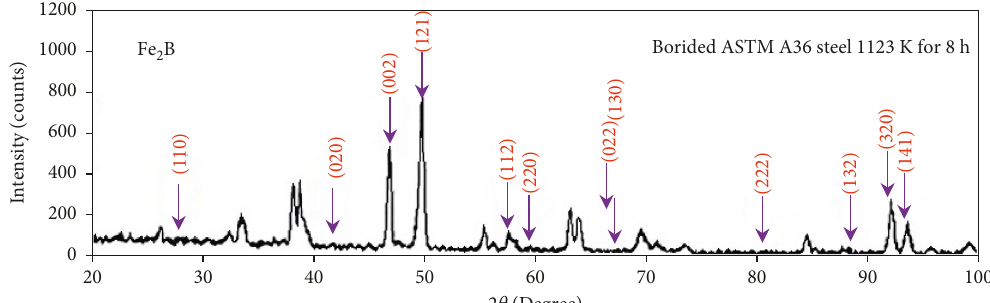
Figure 6: XRD patterns obtained at the surface of the borided ASTM A36. The boriding temperature of 1123K for 8h of